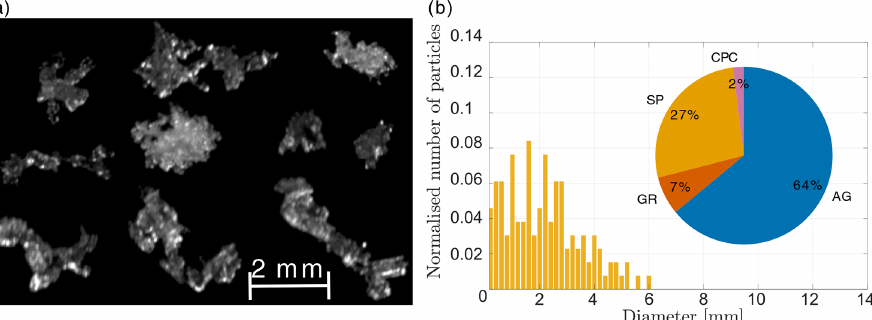
Figure 8. (a) Selection of in-focus MASC images. (b) Normalised size distribution and classification of 55 particles observed from 03:00 to 04:00UTC. SP represents small particles, CC columnar crystals, PC planar crystals, AG aggregates, GR graupel, and CPC a combination of planar and columnar crystals. The size distribution is normalised by the number of particles. The pictures of panel (a) were selected to be representative of the classification. The average temperature was 1.5 ◦ C (Fig.